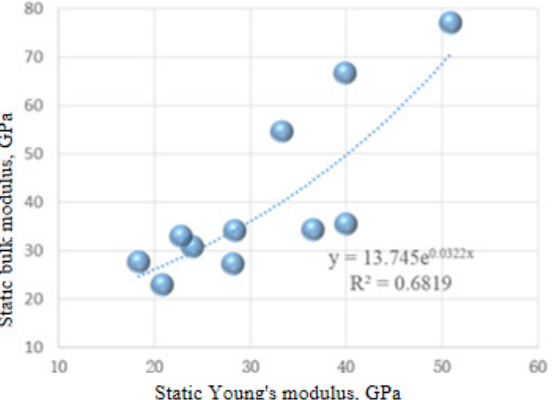
Figure 12. Distribution histogram of dynamic Young’s modulus and bulk modulus.